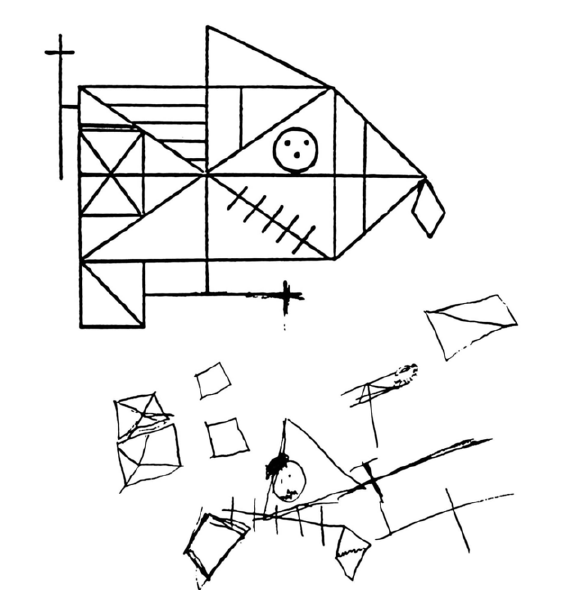
FIG. 2. Rey-Osterrich Complex Figure Copy showirig ex treme degree of fragmentation of her